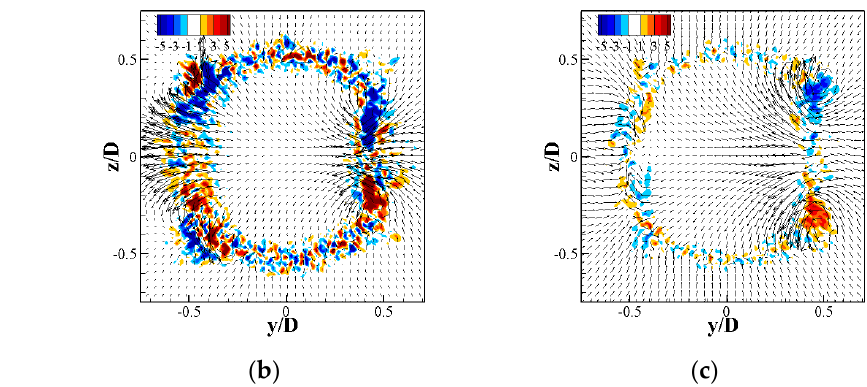
Figure 17. Streamwise vorticity and in-plane velocity vectors for the MFR = 0.67% case at the x / D = 0.5 cross-sectional plane in a time sequence, normalized by U j / D . ( a ) t = 0, ( b ) t = 0.125 T, ( c ) t = 0.5 T.